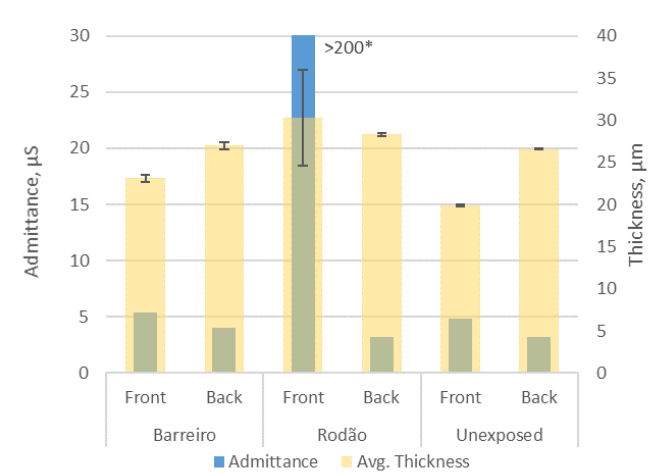
Figure 7. Admittances and thicknesses of the anodic coatings of the Barreiro and Rodão test specimens after 10 years of exposure and of an unexposed test specimen. The error bars plotted represent the standard deviations for anodic coating thickness measurements. * This result exceeds the measuring limit of the apparatus used.